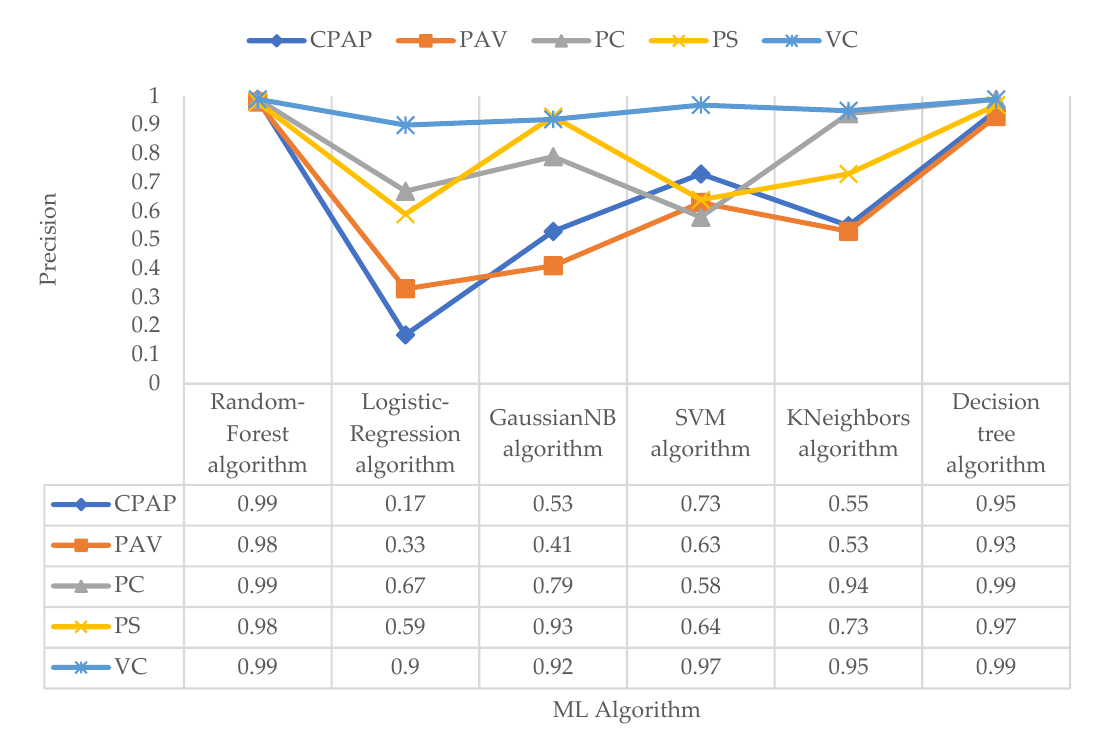
The macro and weighted average of the accuracy values of the various machine learning